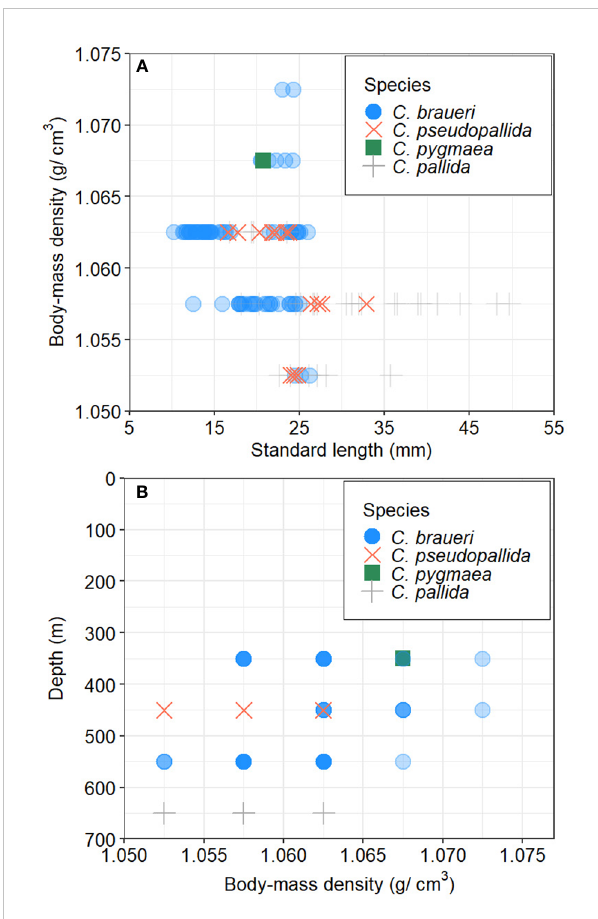
FIGURE 8 Relationship between body-mass density ( r , g·cm − 3 ) and (A) standard length (mm), and (B) depth (m) by Cyclothone